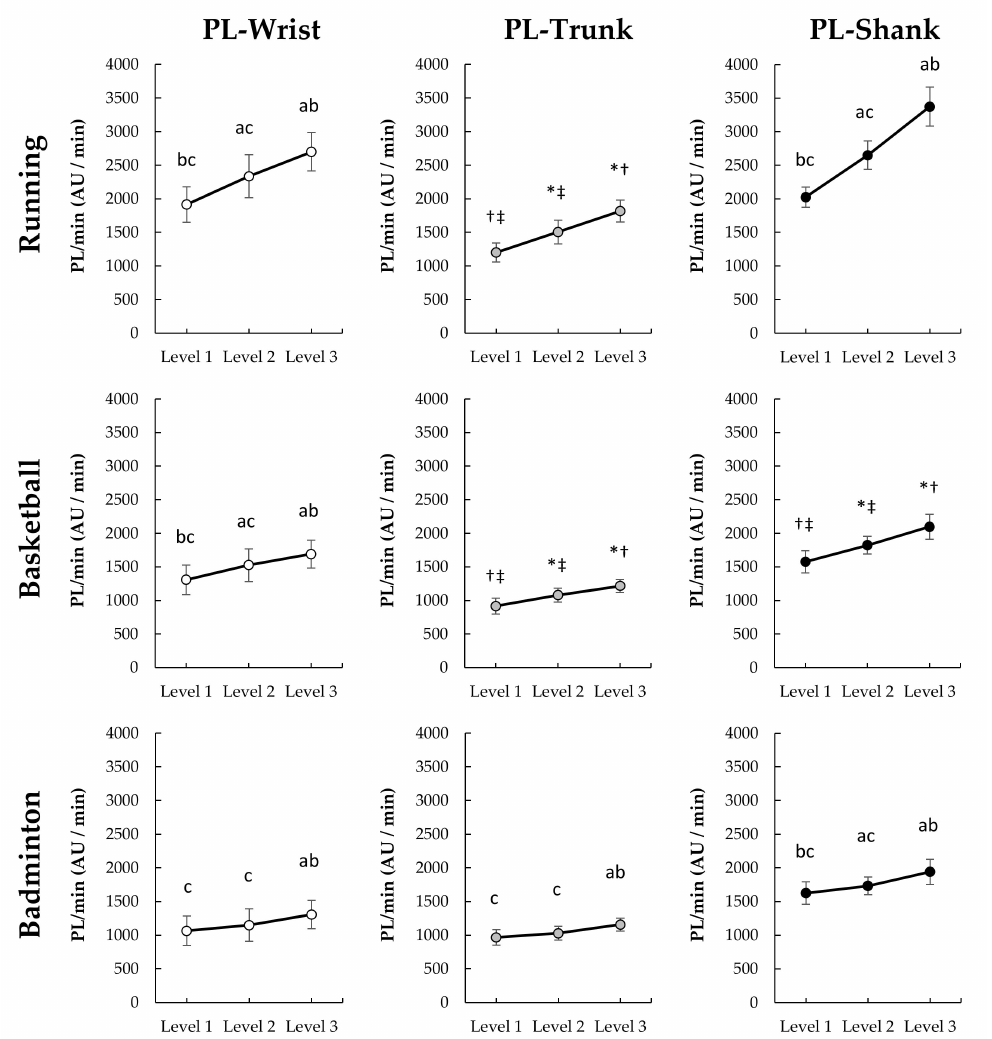
Figure 4. Change of PL/min among three exercise intensity levels under different sports ( n = 14). Bonferroni post hoc test: significantly different than a Level 1, b Level 2, and c Level 3 ( p < 0.05); Wilcoxon signed rank test: significantly different than * Level 1, † Level 2, and ‡ Level 3 ( p <